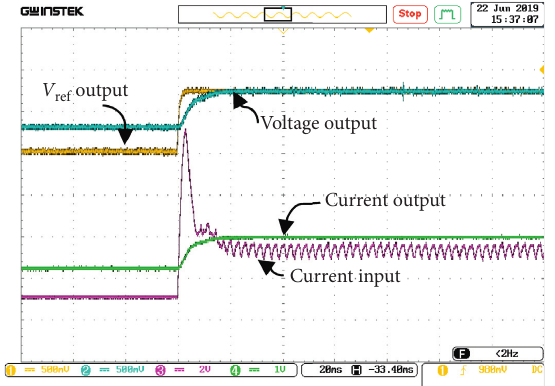
Figure 21: Result of voltage response and current using a PI controller with TS search.